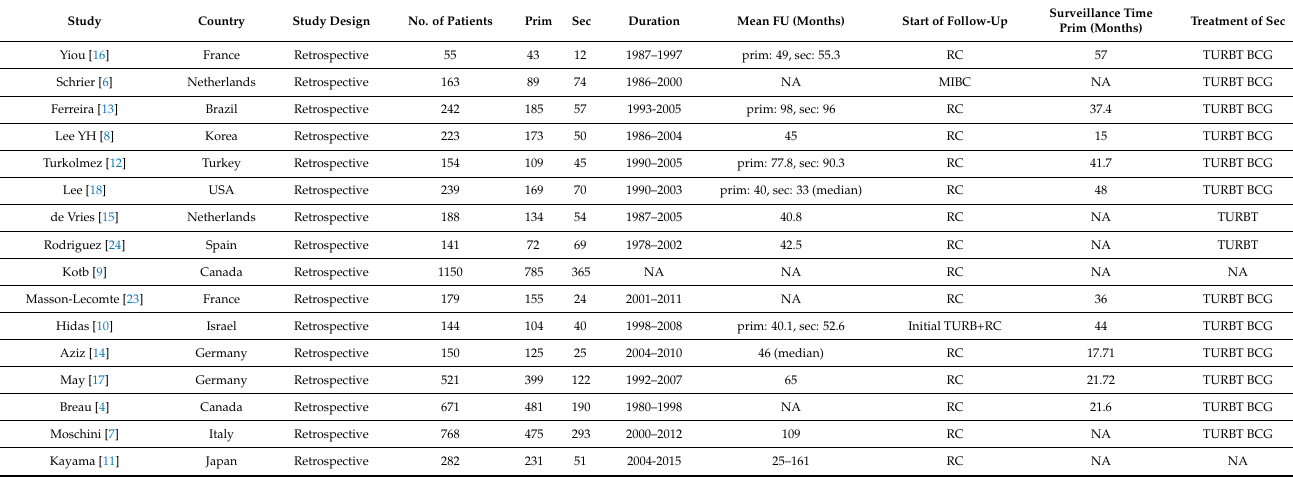
Figure 1. PRISMA 2009 flow diagram. Table 1. Characteristics of included